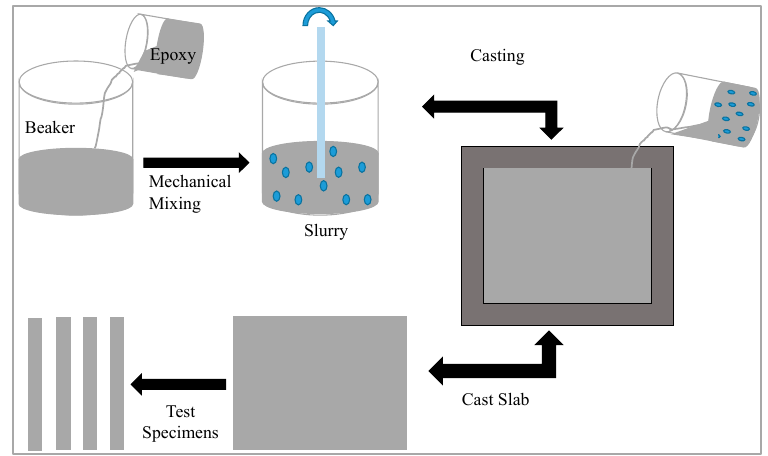
Figure 2. Schematic representation of the fabrication of composites.